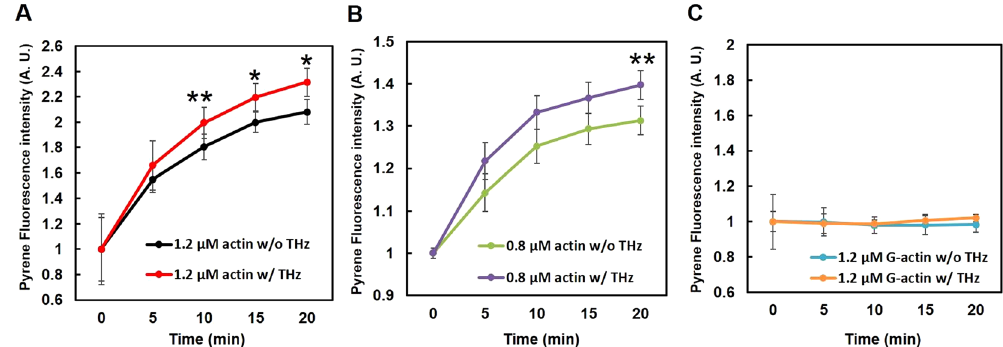
Figure 2. Monitoring of actin polymerization using pyrene actin. ( A and B ) Pyrene-labeled actin solution was polymerized by adding F-actin buffer at the time point of 0, and the increase in the fluorescence of pyrene was observed by using GloMax-20/20 with Luminometer Fluorescent Modules UV (EX: 365–395 nm, EM: 440– 470 nm) with or without irradiation with THz waves (w/THz or w/o THz, respectively). The fluorescent signal was measured every 5 min for 20 min at 25 °C. In panel C, the fluorescence was monitored without adding the F-actin buffer. The initial G-actin concentration was 1.2 μ M ( A and C ), or 0.8 μ M ( B ). The relative fluorescence of pyrene at 0 min was defined as 1.0. Data shown are the mean ± SD of three independent experiments. * P < 0.05, ** P < 0.01.